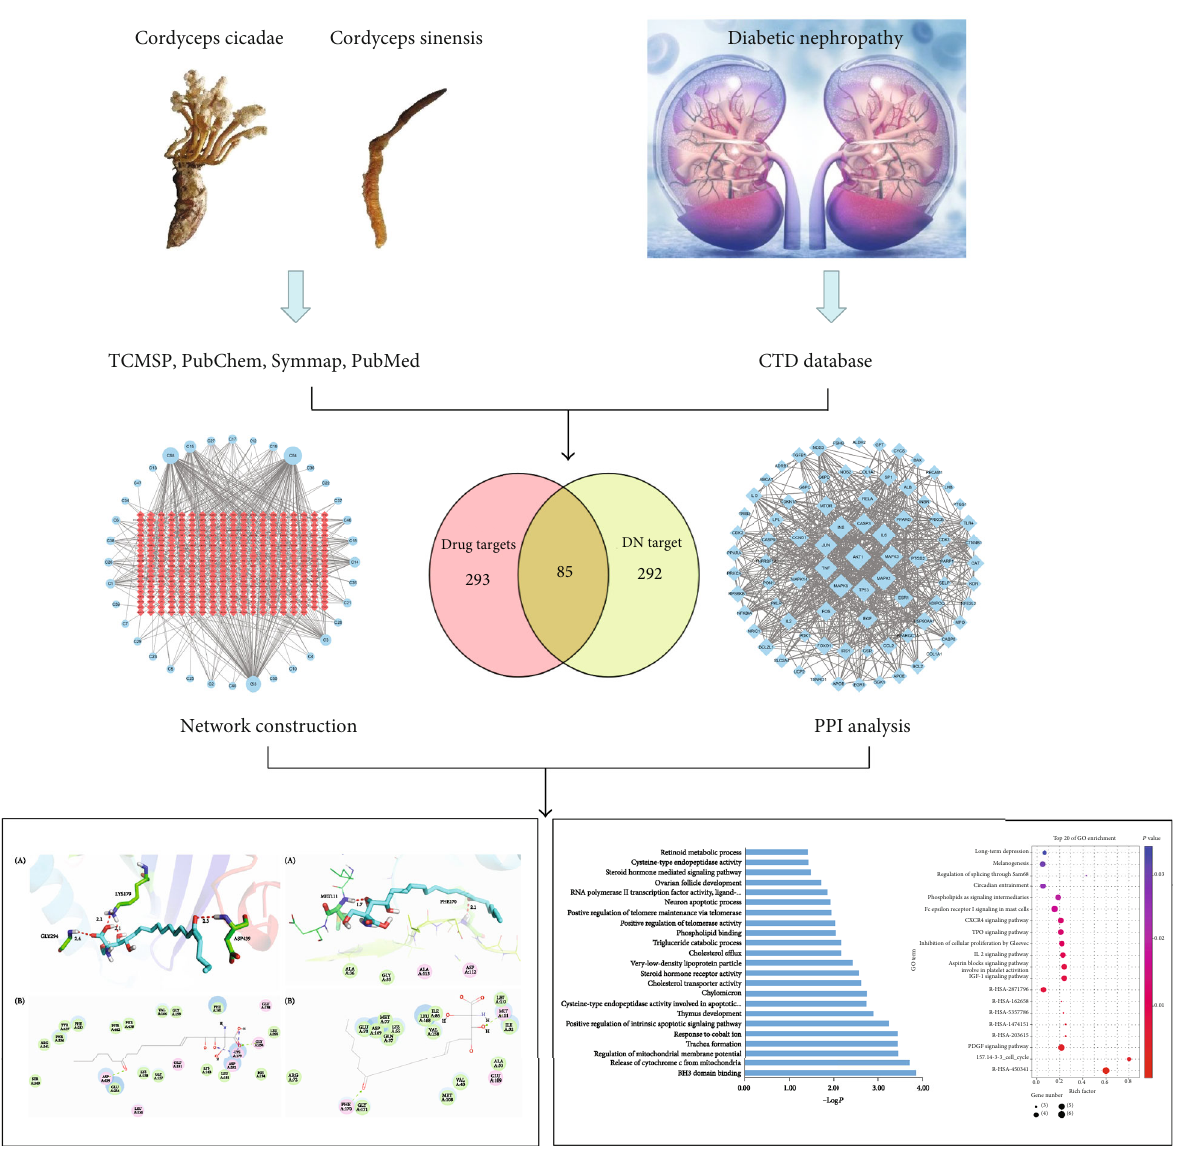
Figure 1: Network pharmacology work fl ow of cordyceps cicadae and diabetic